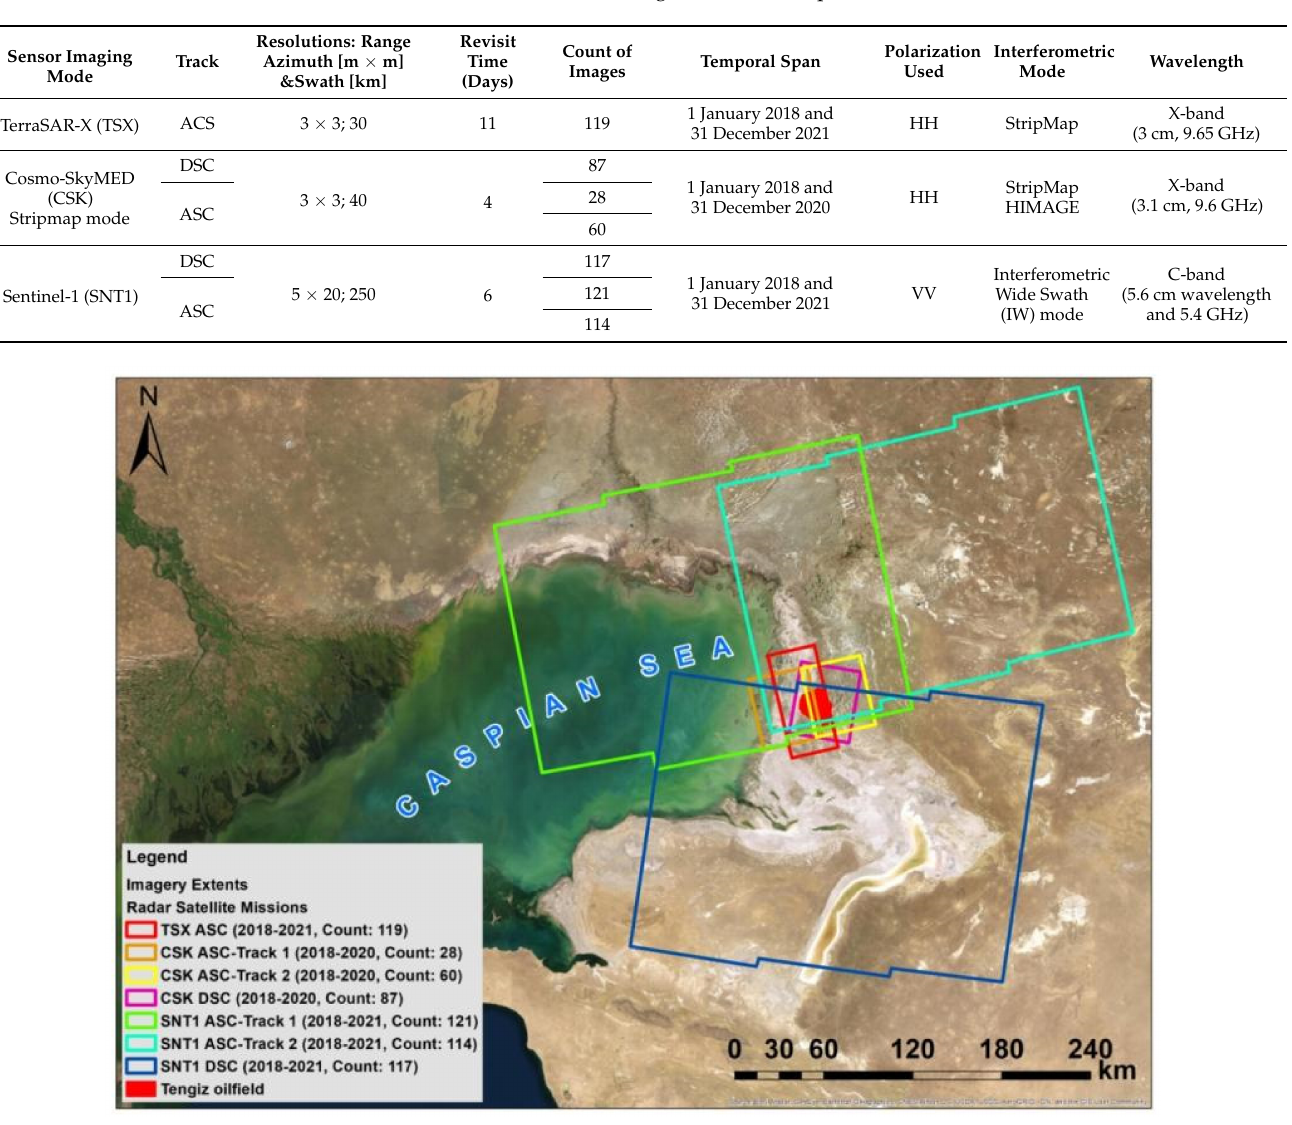
Table 1. Characteristics of SAR images used for the present research [31,32].